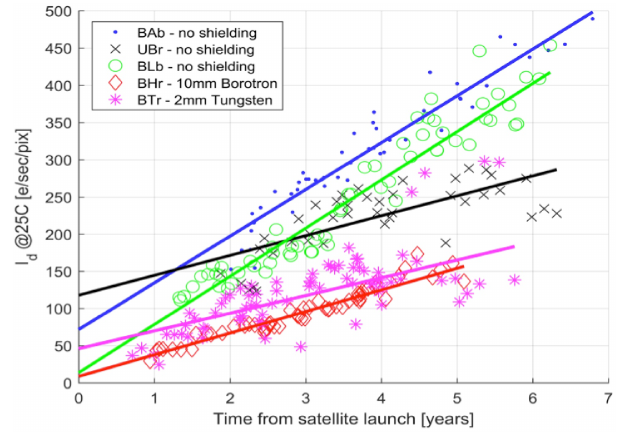
Figure 11. Temporal development of the CCD dark